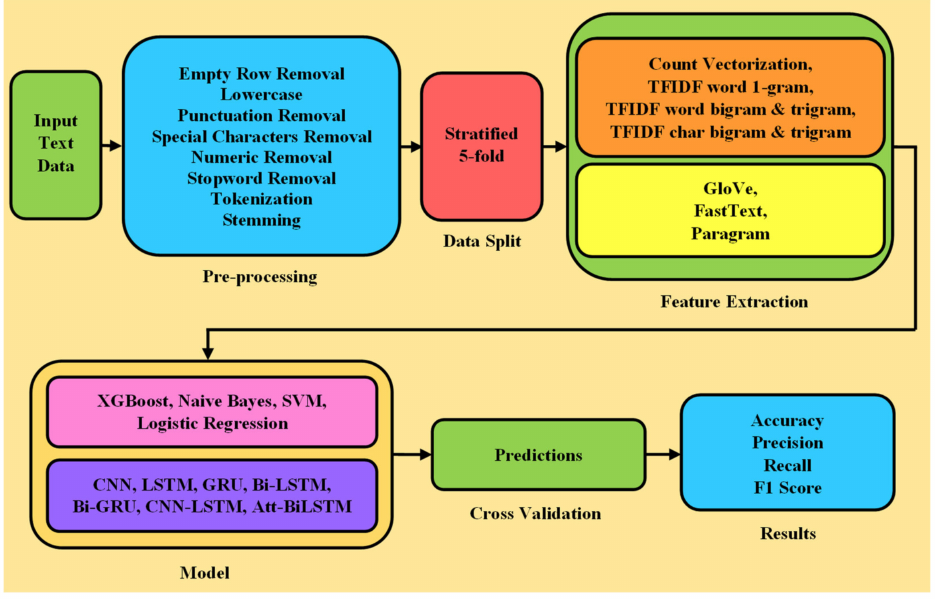
Figure 1. Workflow of the proposed